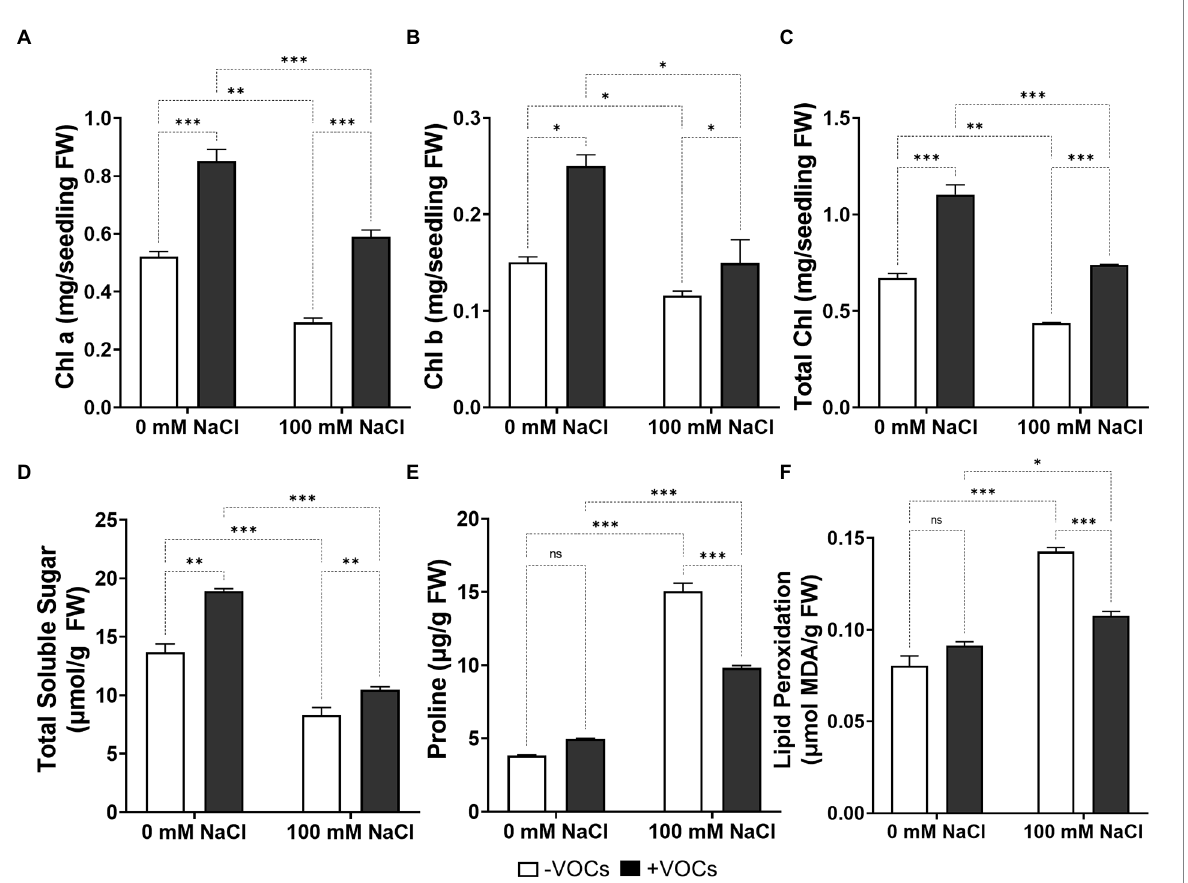
FIGURE 4 Effects of B. pyrrocinia CNUC9 VOCs on changes in (A) chlorophyll a, (B) chlorophyll b, (C) total chlorophyll, (D) total soluble sugar, (E) proline, and (F) malondialdehyde (MDA) content under no-stress (0 mM NaCl) and salt stress (100 mM NaCl) conditions for 10 days. Error bars represent SEM of three independent biological replicates ( n = 20 seedlings per replicate). Asterisks on bars of the same parameters indicate statistical differences among treatments (two-way ANOVA followed by Tukey’s test; * p ≤ 0.05; ** p ≤ 0.01; *** p ≤ 0.001; n = 60). ns, non